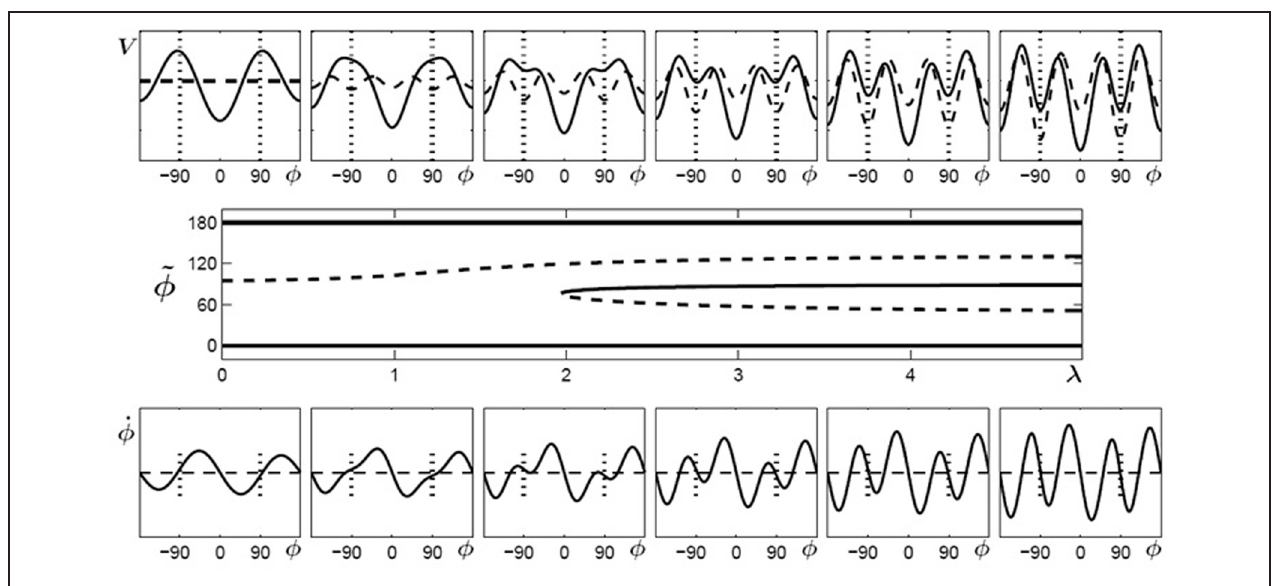
bifurcation occurs, leading to an additional unstable fixed point (dashed) and an attractor (solid) close to the required phase of ψ = 90 ◦ (only the upper half of the bifurcation diagram is shown since the part for negative values of φ is